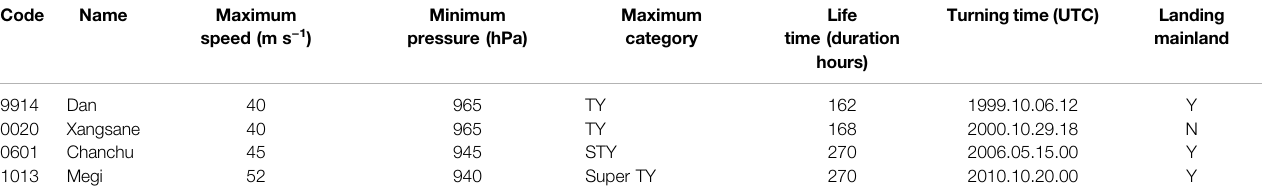
TABLE 1 | The information of four typhoon cases over the south China sea.